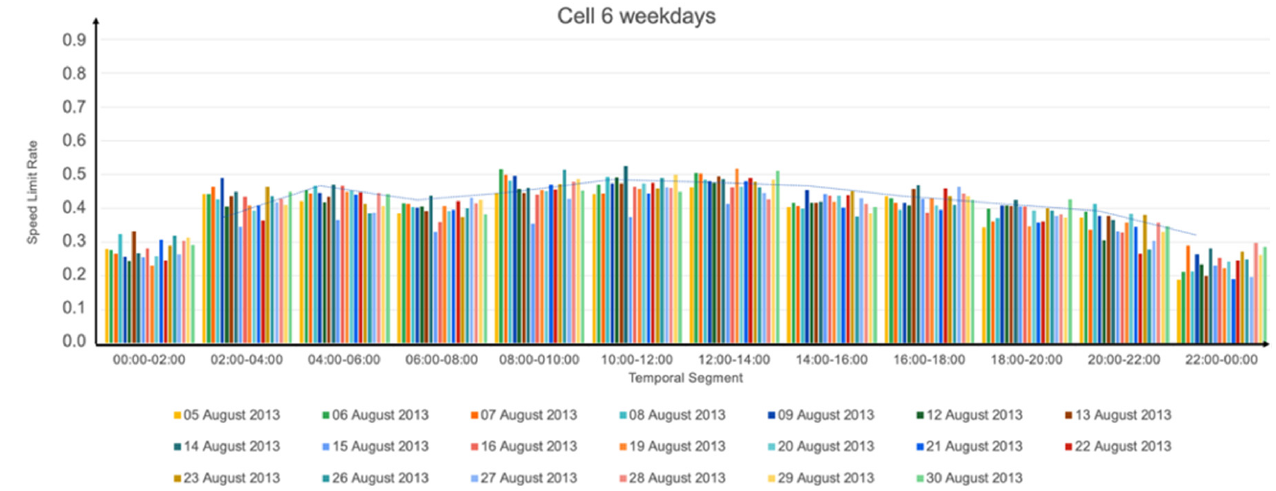
Figure 13. Calculated speed limit rates for the weekdays, cell 6 with MaxSpeed = 50 km/h. Considering all the results, first and second experiments, we highlight the following. On